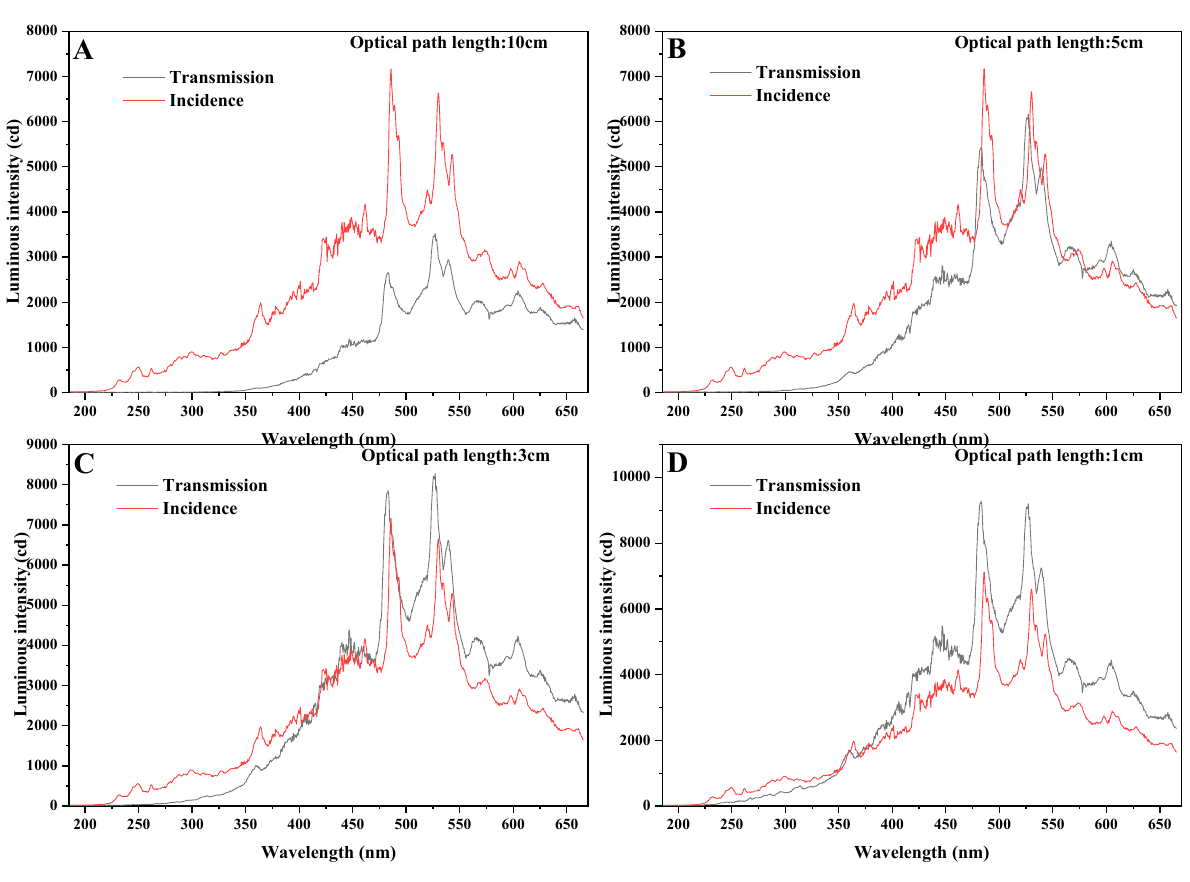
Figure 3. Comparison of incident and transmission luminous intensities for ( A ) 10 cm, ( B ) 5cm, ( C ) 3 cm, and ( D ) 1 cm optical path lengths.